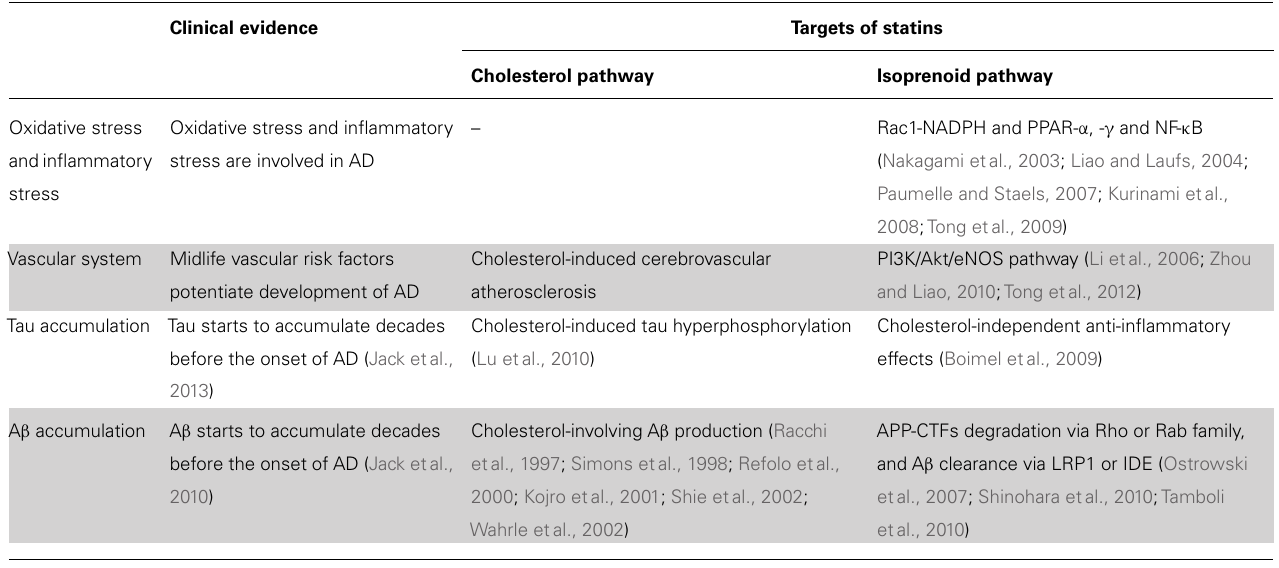
Table 2 | Summary of presumable beneficial actions of statin use in midlife onAD pathogenic stress and